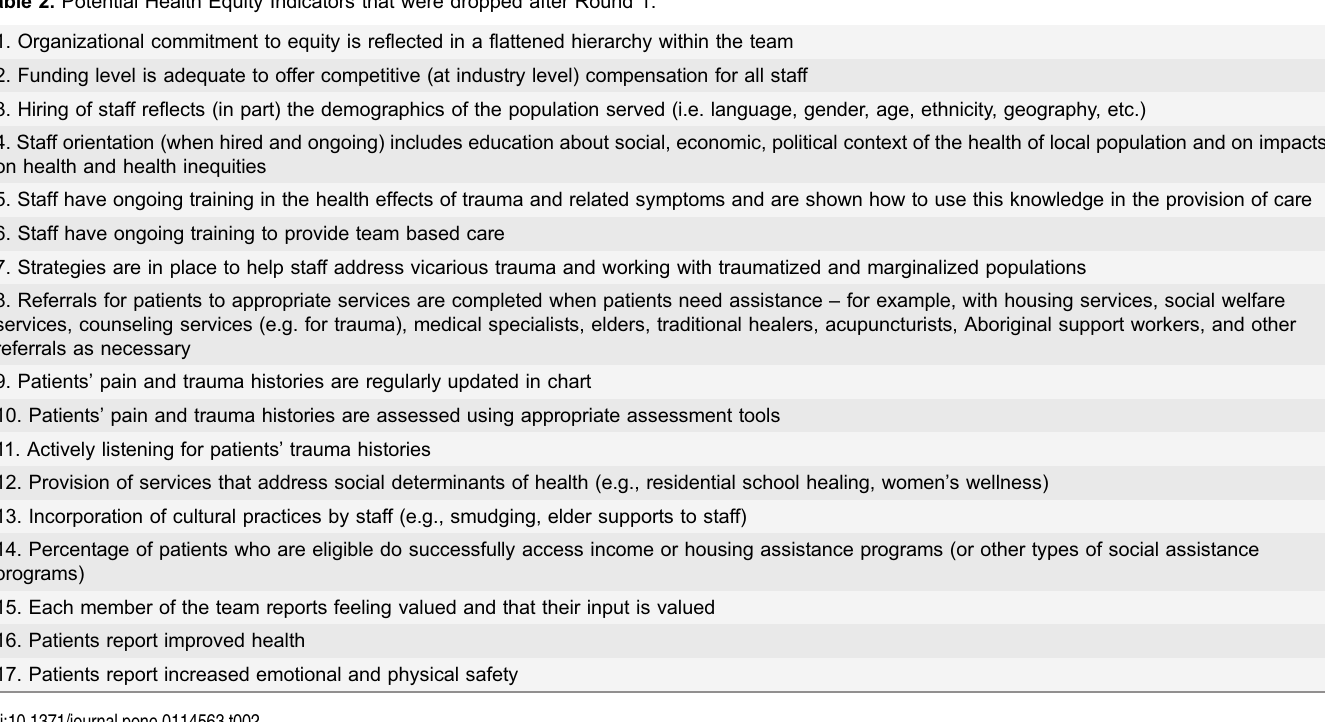
Table 2. Potential Health Equity Indicators that were dropped after Round